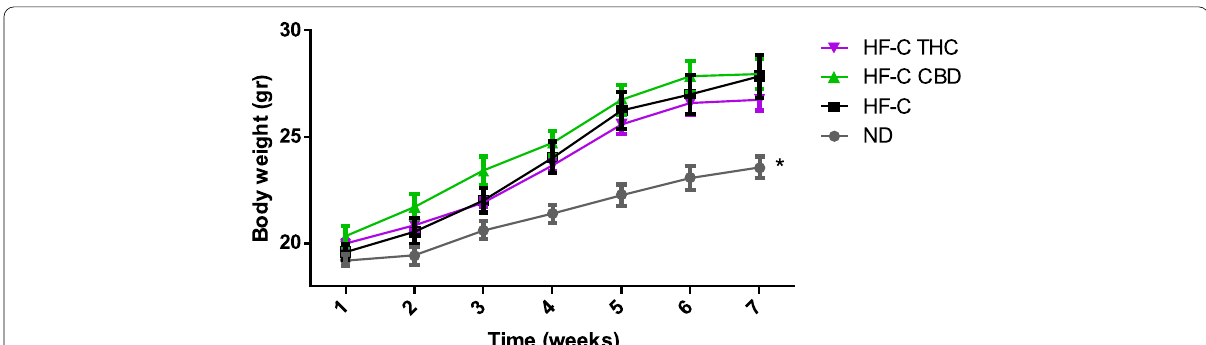
Fig. 1 Effect of THC or CBD treatment on body weight gain in mice fed HFCD. Male C57BL/6J mice aged 7–8 weeks were fed either normal diet (ND, n 8), high fat 1%(w/w) cholesterol 0.5%(w/w) cholate diet (HF‑C, n = + + containing THC (2.5 mg/kg) (HF‑C THC, n 8). Body weight was measured weekly over the experiment duration. All values are expressed as mean = SEM. *( p < 0.05) according to Student’s t ‑test ±